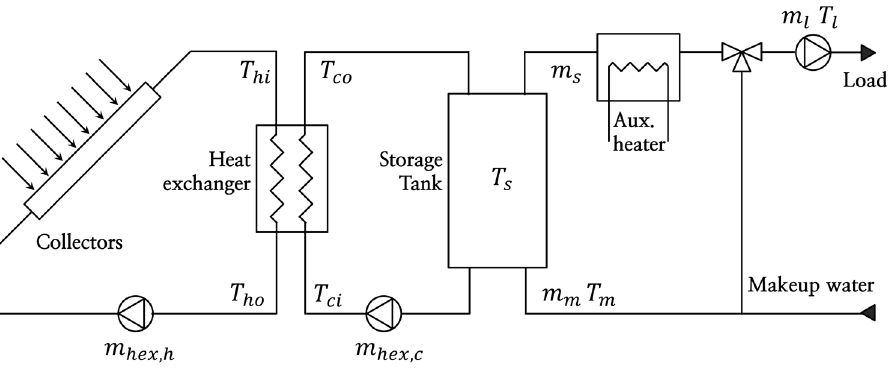
Figure 1. Schematic diagram of the SWH system considered in this